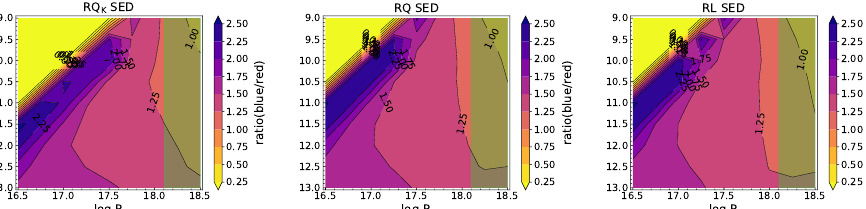
Figure A3. Results of CLOUDY simulations: the three panels yield the ratio R FeII ˜B to R FeII ˜R (in practice ˜B/ ˜R) as a function of density and BLR radius, for the RQ Korista et al. [89] ( leftmost ), the RQ Laor et al. [104] ( middle ) and RL SED ( rightmost ).